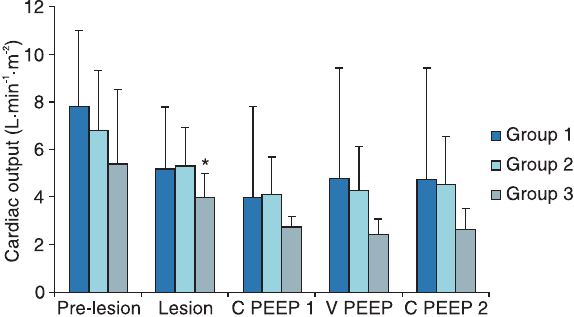
Figure 3. Mean arterial pressure is reported as means ± SD for all groups. See Figure 1 for explanation of abbreviations. P > 0.05 (Tukey-Kramer